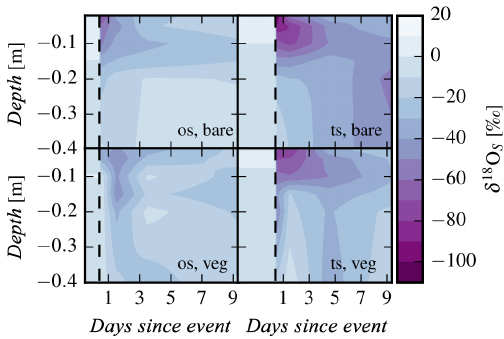
Figure 2. Mean daily isotopic composition of soil water δ 18 O S dur- ing experiment under bare soil (bare) or vegetation cover (veg) at open sites between tree crowns (os) and shaded sites beneath tree crowns (ts). Dashed lines mark time of watering event. Interpola- tion method: linear. The standard error for soil isotopic composi- tion during the experiment amounts on average to 1.4‰ in natural abundance. Figure 3. Mean daily soil water content θ along soil depth separated